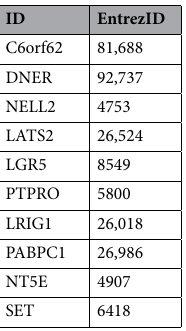
Table 1. ENSEMBL/Entrez gene